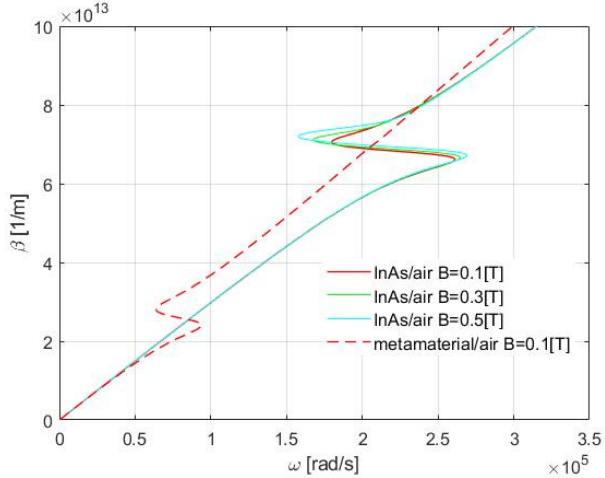
Figure 4. Dispersion maps of the surface plasmon polaritons propagating at the boundary of anisotropic semiconductor.